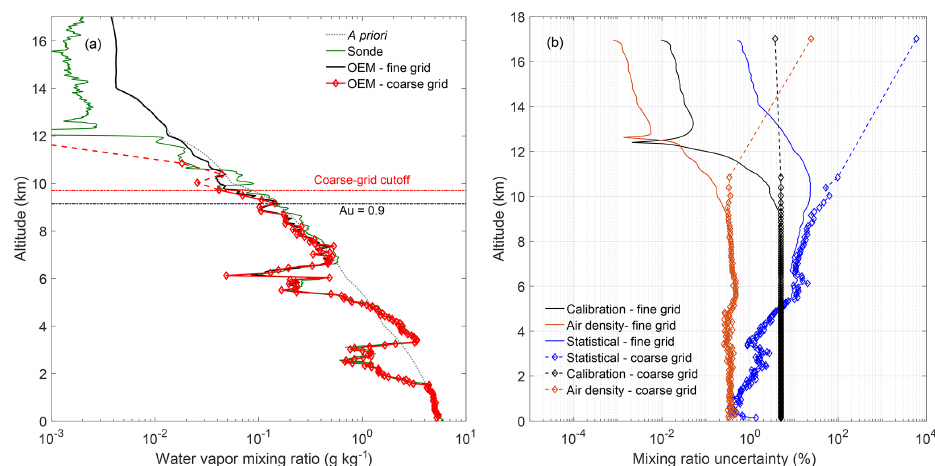
Figure 11. (a) The water vapor retrieval for 24 April 2013 00:00UT. The fine-grid retrieval is in black; the coarse-grid retrieval is in red. In general, both OEM retrievals on the coarse and fine grid and the radiosonde agree until the original cutoff altitude at 9.1km (dashed black line). The dashed red lines above 9.7km show the points we do not consider meaningful due to their large uncertainties. Therefore, the a priori removal technique increases the last altitude bin by 600m. The method is limited by the lack of water vapor in the upper troposphere which causes a large and rapid drop in signal. (b) The three largest relative uncertainty components are compared here on the fine and coarse grid. The drawback of the a priori removal technique is that while you gain in altitude, you increase the uncertainty. At 9.7km the statistical uncertainty is 52%, above which is where we no longer consider the rest of the retrieval to be viable.